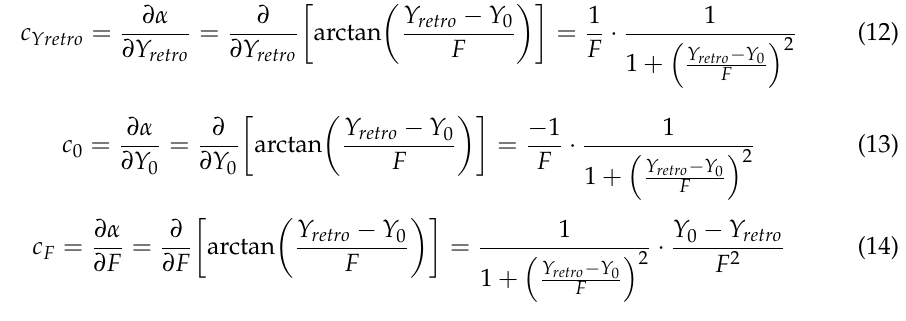
Table 1. Uncertainty of the angular misalignment α